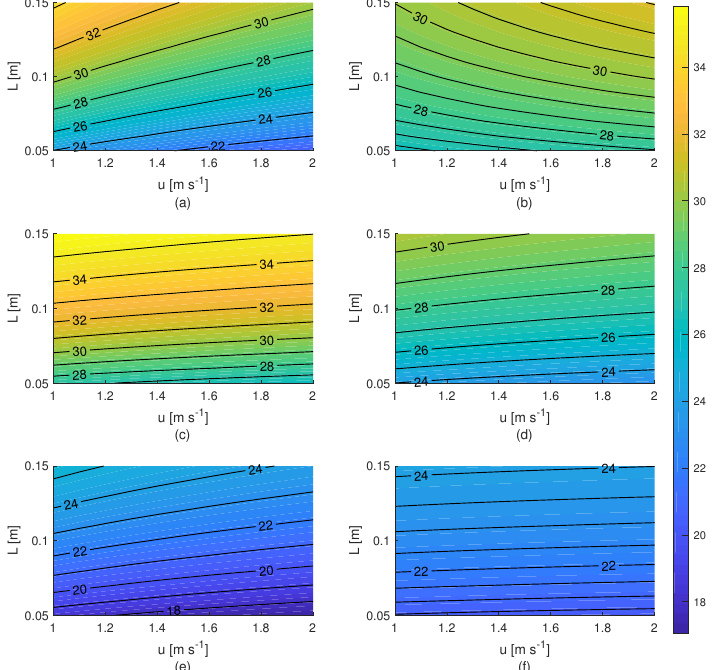
Figure A11. Difference between the outlet and inlet pad air relative humidity ( ∆ φ ) as a function of inlet air velocity ( u ) and pad thickness ( L ) for the pad materials studied. ( a ) Cellulose. ( b ) Small co- conut shell (7.9–12.7 mm). ( c ) Big coconut shell (12.7–19.0 mm). ( d ) Burnt-clay bricks (12.7–19.0 mm). ( e ) Small pumice stones (34.9–45.0 mm). ( f ) Big pumice stones (45.0–55.5